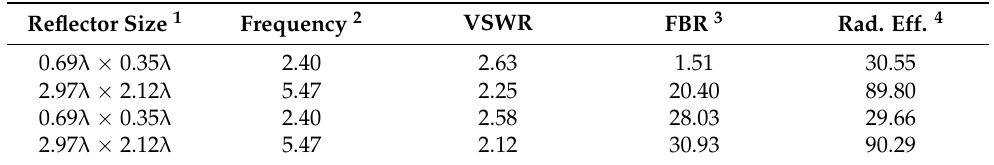
Figure 2. Voltage Standing Wave Ratio ( VSWR) at a different: ( a ) reflector size; ( b ) cotton-layer thickness; ( c ) logo elements size. The dimensions of the other antenna elements are those shown in Figure 1. The reflector size is in wavelengths, where Lambda is the free-space wavelength at 2.44 GHz (central frequency for the ISM 2.4 GHz). Table 1. Antenna parameters at different reflector sizes (the cotton layer and logo elements are with the dimensions shown in Figure 1c).